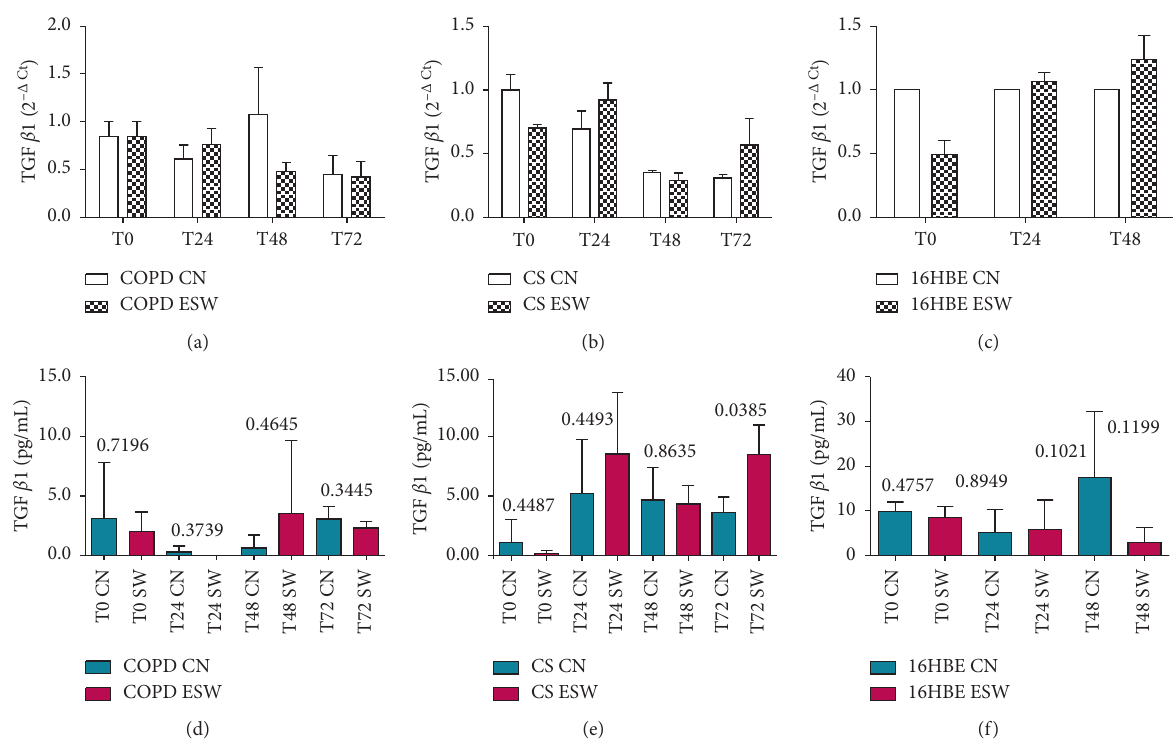
Figure 5: TGF β 1 mRNA (a, b, c) and protein (d, e, f) expression after ESW treatment in primary bronchial fibroblasts of COPD patients (a, d), primary bronchial fibroblasts of control smokers (b, e), and bronchial epithelial cells (c, f). In primary bronchial fibroblasts of control smokers, TGF β 1 increased at protein level at 72h (e). T -test was used for comparative purposes, and p values are reported in the graphs.